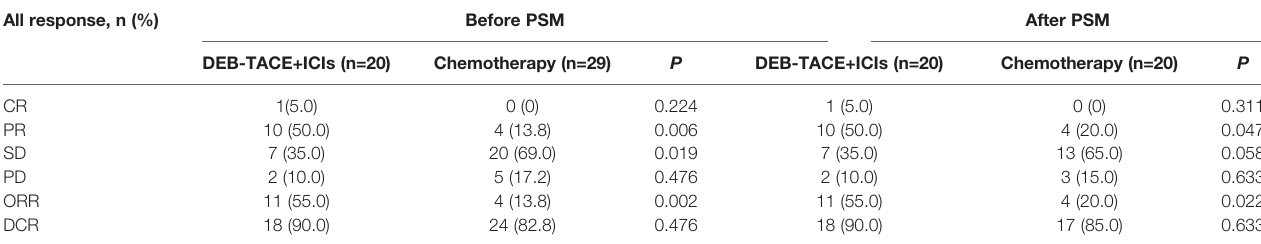
TABLE 2 | Summary of response rates before and after PSM.